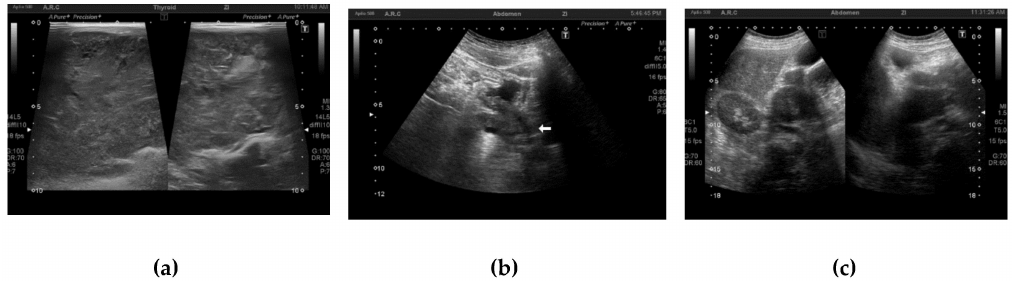
Figure 3. Screenshots of ultrasound video sequences. ( a ) Thyroid (SM), ( b ) stomach (MM) and ( c ) gallbladder (HM).